Question: Give a one-sentence summary of this figure.
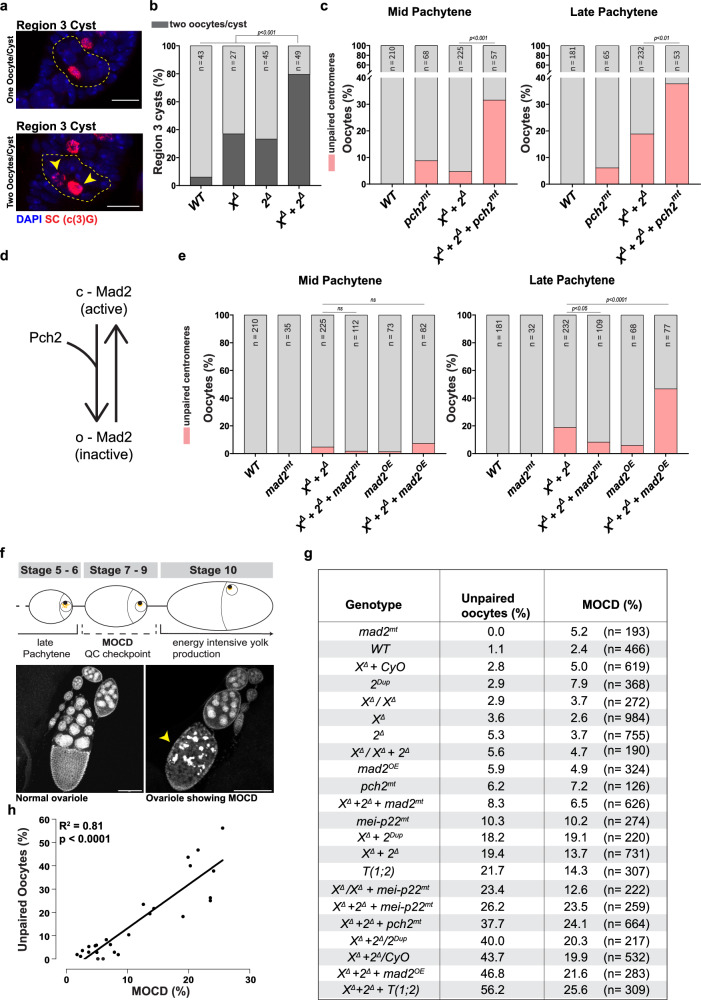
Answer: Loss of satellite DNA homology activates meiotic checkpoints and triggers cell death. a IF against the transverse filament of the synaptonemal complex C(3)G (red) in the outlined region 3 cysts and co-stained with DAPI (blue). The arrow indicates the second oocyte with a persistent C(3)G signal. b Quantification of region 3 cysts showing the double oocyte phenotype in the indicated genotypes. n indicates the number of cysts analysed, and p -values were obtained from a two-sided Fisher’s exact test. c Quantification of oocytes with > 4 dCenp-A foci, indicating unpaired centromeres, in mid and late pachytene in the indicated genotypes. pch2 was mutated using the pch2 EY01788 allele in trans to Df(3 R) Bsc195 . d Schematic showing the regulation of Mad2 activity by Pch2. e Quantification of oocytes with > 4 dCenp-A foci, indicating unpaired centromeres, in mid and late pachytene in the indicated genotypes. mad2 was mutated using the mad2 EY21687 allele in trans to mad2 P . mad2 OE represents an extra copy of a GFP::Mad2 transgene. f Schematic of the quality control mid-oogenesis checkpoint (MOCD) at Stg 7–9 of oogenesis. A healthy ovariole (bottom left) and an ovariole exhibiting MOCD (bottom right) are co-stained with DAPI. Arrowhead points to the Stg. 8 egg chamber undergoing MOCD with pyknotic nuclei g , Table indicating percentage of oocytes with unpaired centromeres in late pachytene and corresponding percentage of Stg 7–9 egg chambers with MOCD from the indicated genotypes. n indicates the total number of Stg 7–9 egg chambers scored. h Correlation between centromere unpairing and MOCD from ( g ). R 2 and slope were determined from a linear regression analysis. n indicates the number of oocytes analysed, and p- values were obtained from a two-sided Fisher’s exact test. ns indicates p > 0.05. WT and X Δ + 2 Δ unpaired centromere values were reused from Fig. 1e . Source data are provided as a Source Data file. p- values of individual comparisons can be found in Supp